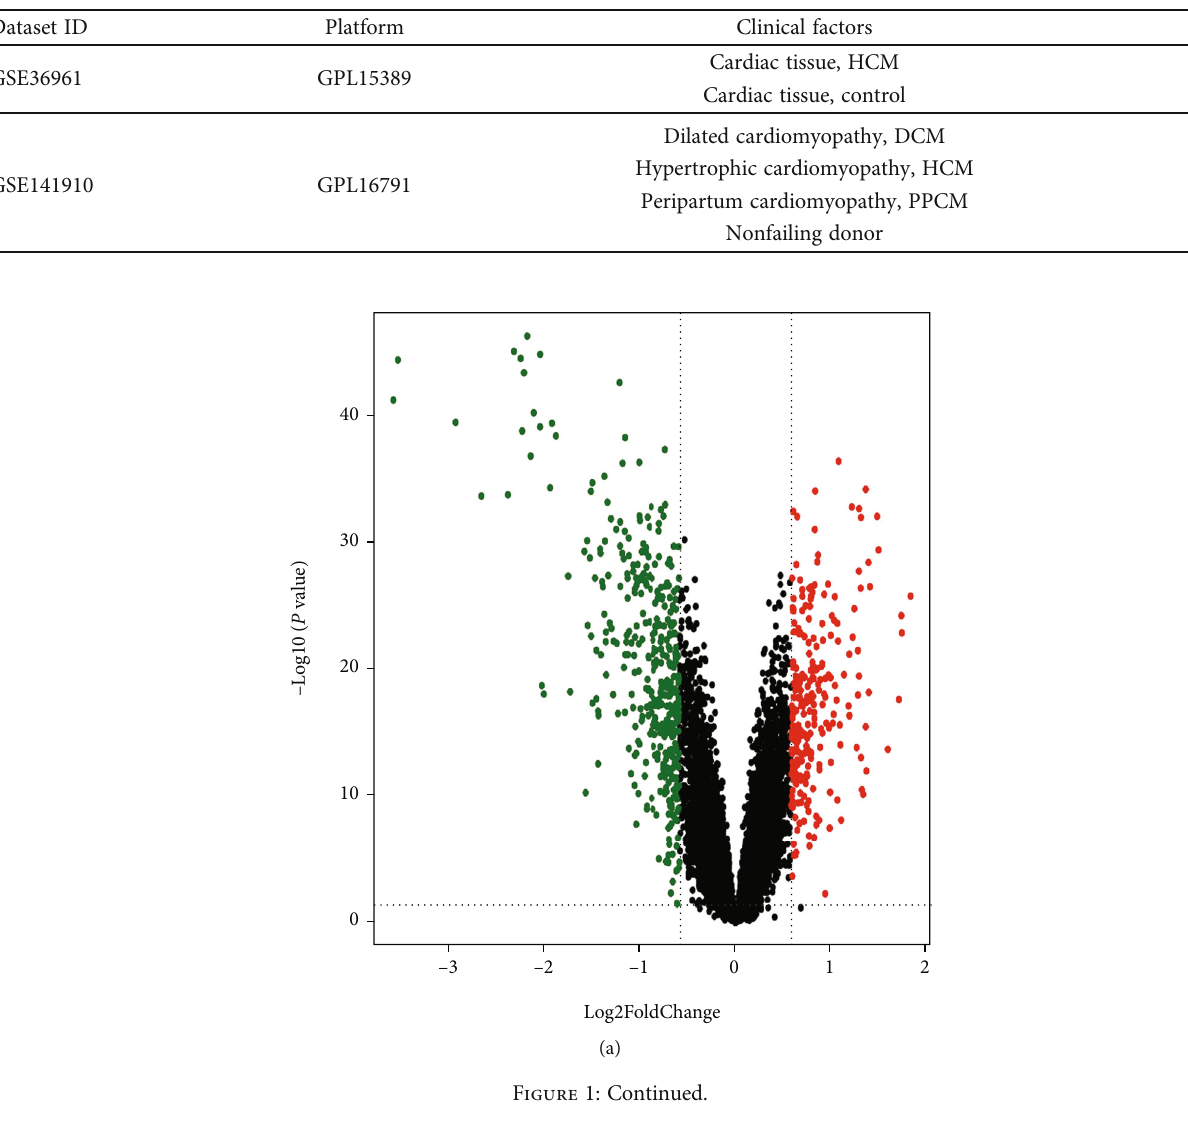
Table 1: Dataset